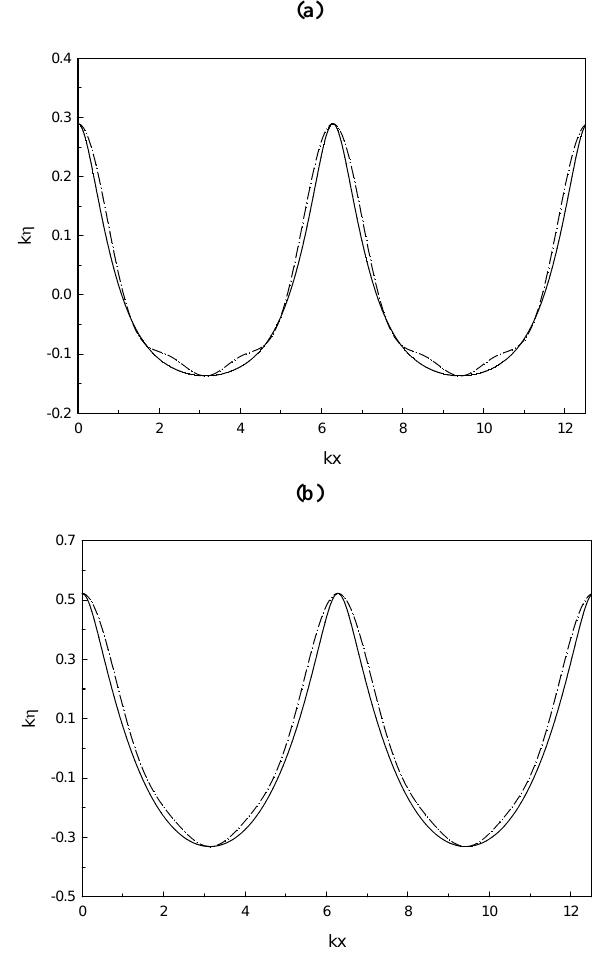
Fig. 4. A comparison on the wave profiles for the Eulerian and Lagrangian solutions both to a third-order under different current Figure 4. A comparison on the wave profiles for the Eulerian and Lagrangian conditions (a) F r = 0 . 3, (b) F r =− 0 . 2. Wave conditions d/L = 0 . 2 and H/L = 0 . 1 (Solid line: third-order Lagrangian solution; dash- solutions both to a third-order under different current conditions (a) , (b) dotted line: third-order Eulerian Figure 4. A comparison on the wave profiles for the Eulerian and Lagrangian . Wave conditions (Solid line: third-order solutions both to a third-order under different current conditions (a) , (b) Lagrangian solution; dash-dotted line: third-order Eulerian solution) . Wave conditions (Solid line: third-order Lagrangian solution; dash-dotted line: third-order Eulerian solution)